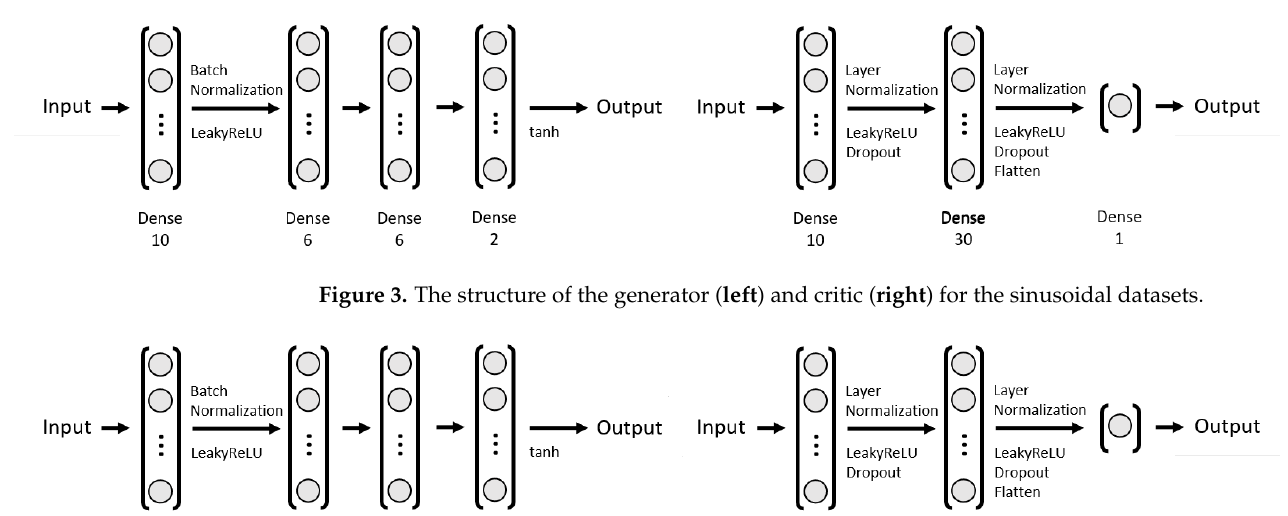
Figure 2. Sinusoidal dataset with added noise ( η = 0.2, see Equation (8)). The test data is shown on the left, sampled points from the WGAN are shown in the middle and sampled points from the GPR posterior are shown on the right.